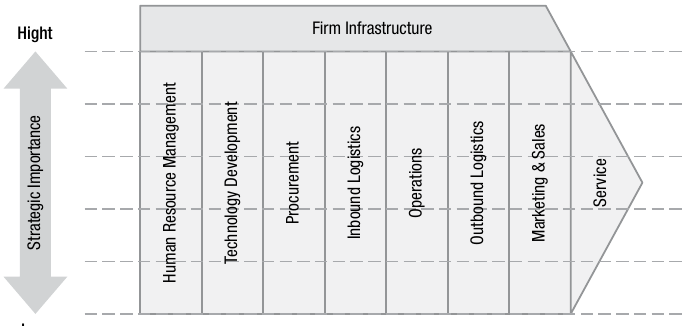
Fig. 2. A new value chain configuration in the fine-slicing context Source: Adapted from Porter (1987).